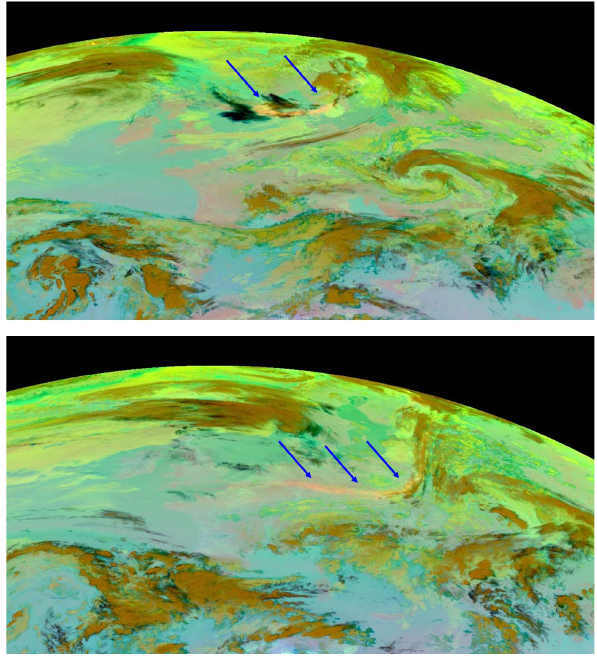
Fig. 2. METEOSAT SEVIRI “ash product” from 16 April, 00:00UTC (upper panel). The bow-shaped volcanic plume is appar- ent over the North Sea between England and Southern Scandinavia. The same type of image from 16 April, 18:00UTC (lower panel) shows ash signatures over the Benelux area, Germany, Poland and the Czech Republic. Blue arrows indicate the position of the vol- canic plume which is colour-coded in